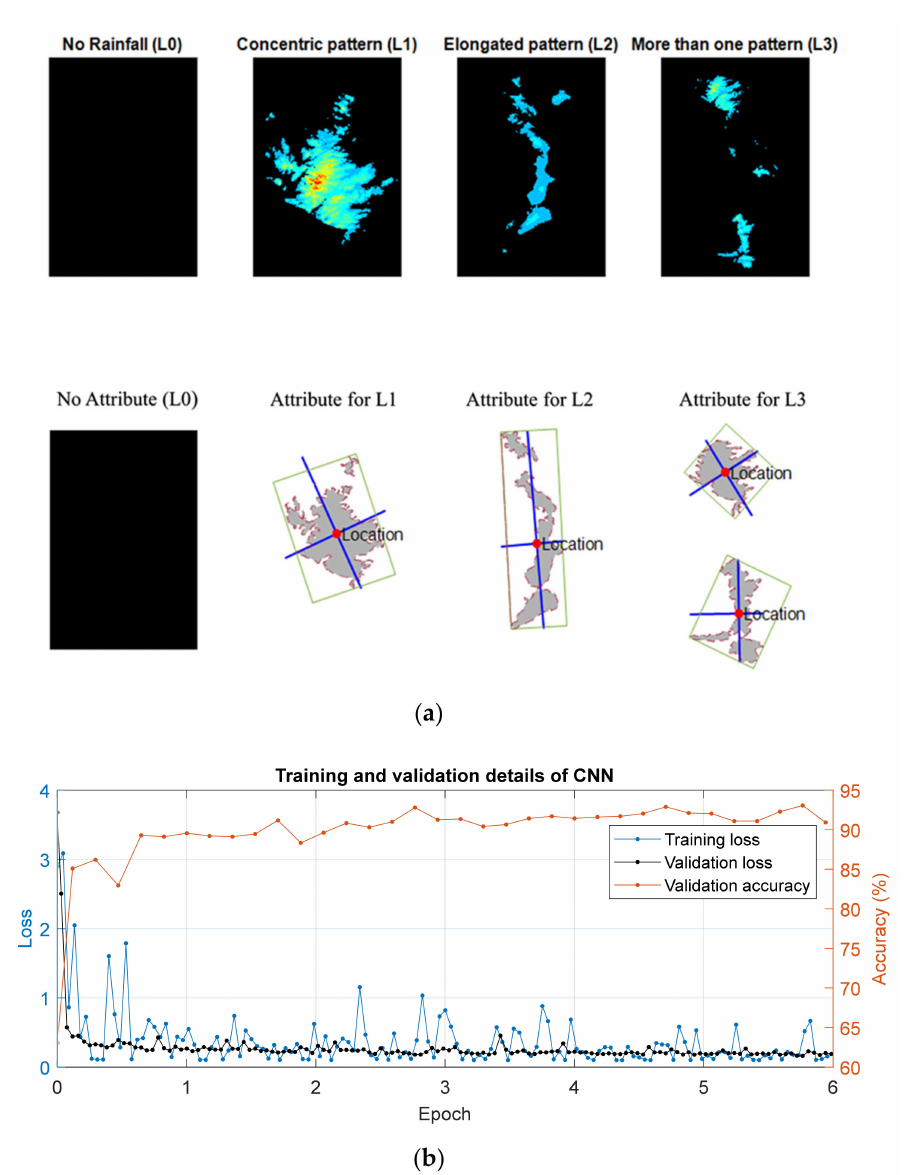
Figure 7. Four labels corresponding to the daily rainfall patterns: no rainfall (L0), concentric pattern (L1) where its sp is near 1.0, elongated pattern (L2) and compound pattern (L3) which has both concentric and elongated types ( a ); and the training and validation loss (blue and black lines) and validation accuracy (orange lines) of CNN ( b